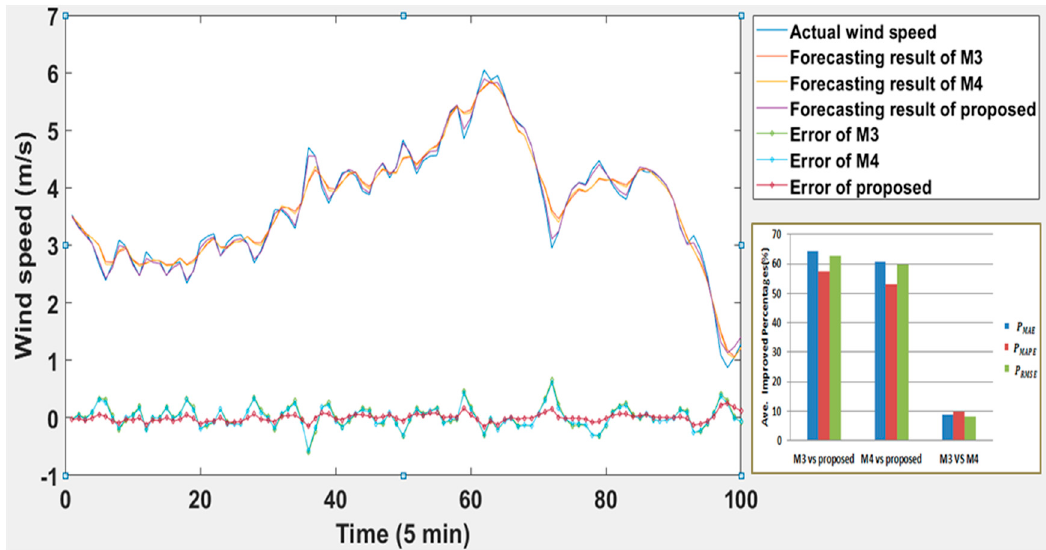
Figure 10. Comparison of different combinations.